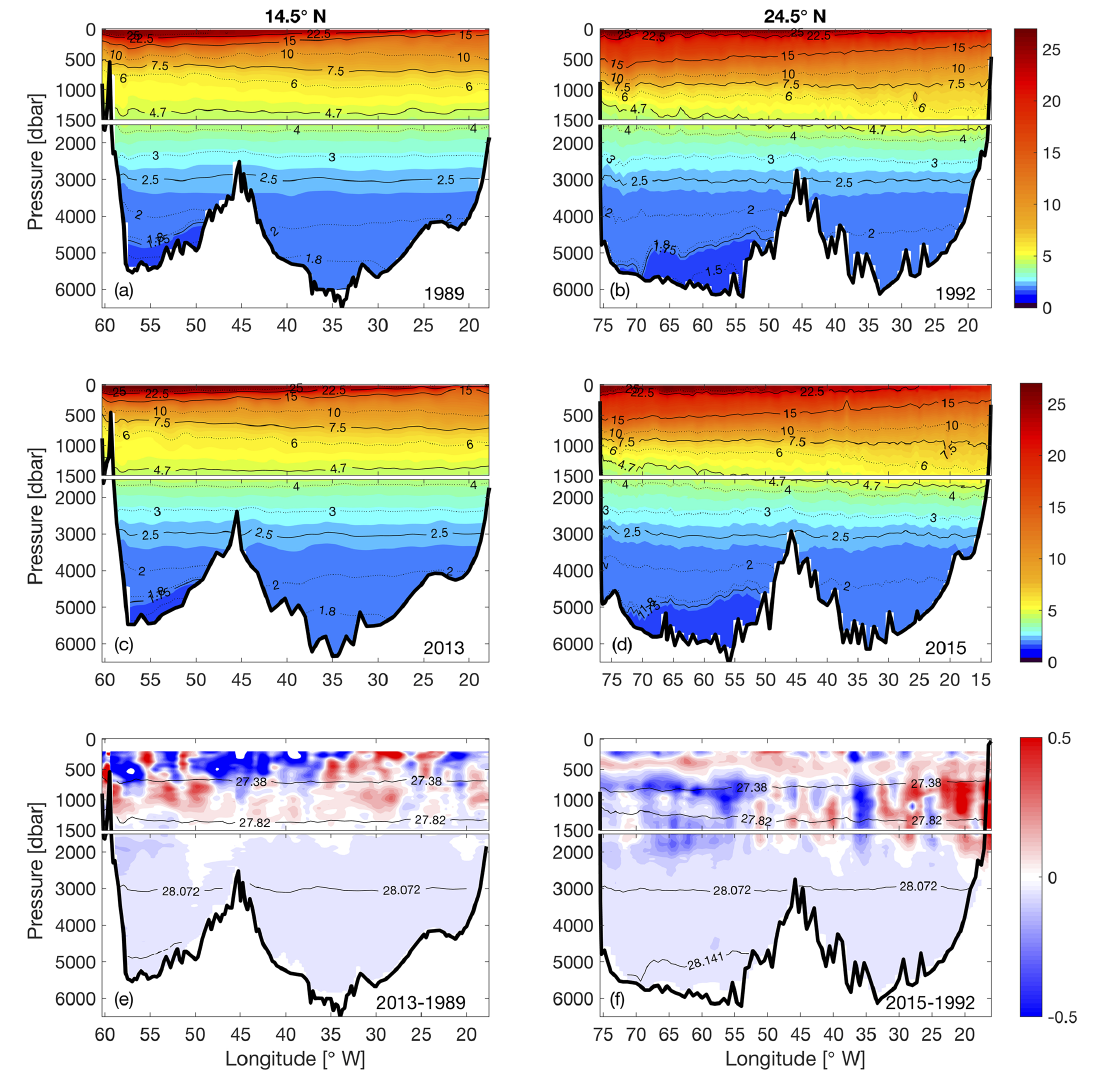
Figure 4. Vertical sections of potential temperature ( ◦ C) at 14.5 ◦ N in (a) 1989 and (c) 2013 and at 24.5 ◦ N in (b) 1992 and (d) 2015. Further shown is the potential temperature difference at (e) 14.5 ◦ N between 2013 and 1989 and (f) 24.5 ◦ N between 2015 and 1992. Note that the difference is calculated first on neutral density levels and then transformed back to depth levels, and that the upper 200m is neglected. The contours in (e) and (f) are the neutral density surfaces of 27.38, 27.82, 28.072, and 28.141kgm − 3 , which mark the boundaries of AAIW, UNADW, LNADW, and AABW. The upper 1500m in each subplot is